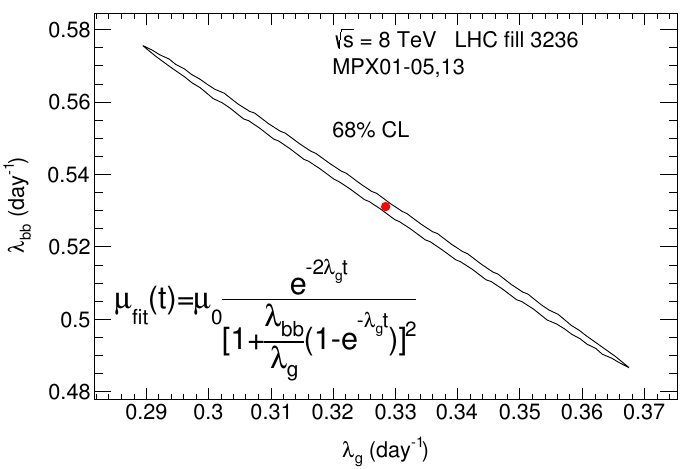
Figure 14. Contour curve of λ g and λ bb , given at 68% CL, for the fit results of the average number of interactions per bunch crossing as a function of time using combined data from MPX01-05 and MPX13, shown in Figure 13. The dot in the center of the contour indicates the fit values. LHC fill 3236. Taken from